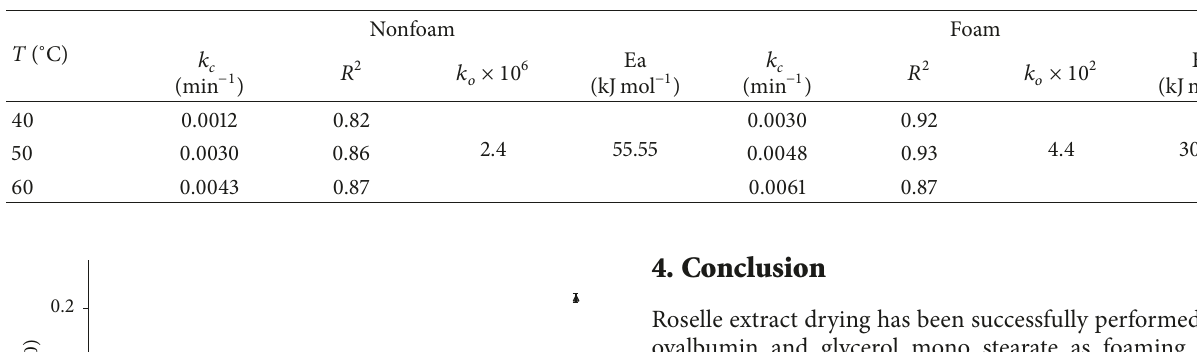
Table 7: The Arrhenius parameters for colour degradation.